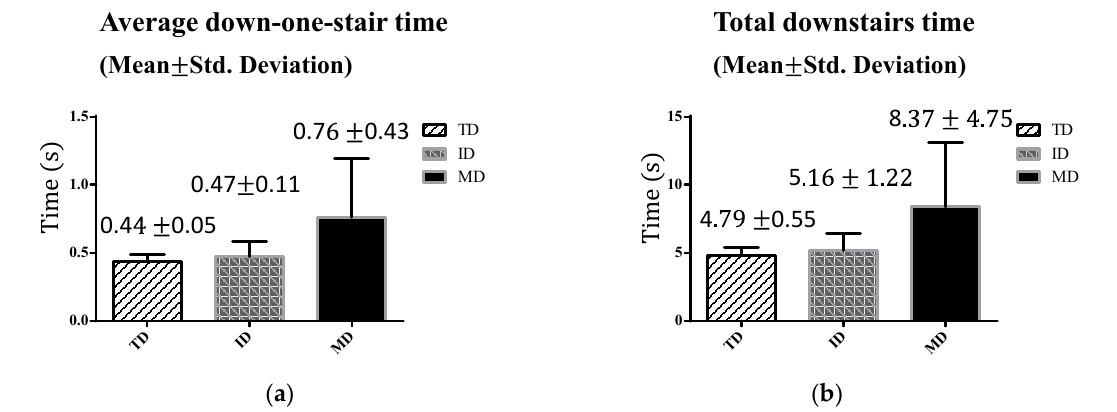
10 of 14 Table 4. Post hoc tests of upstairs walking for three groups. Dependent Variable